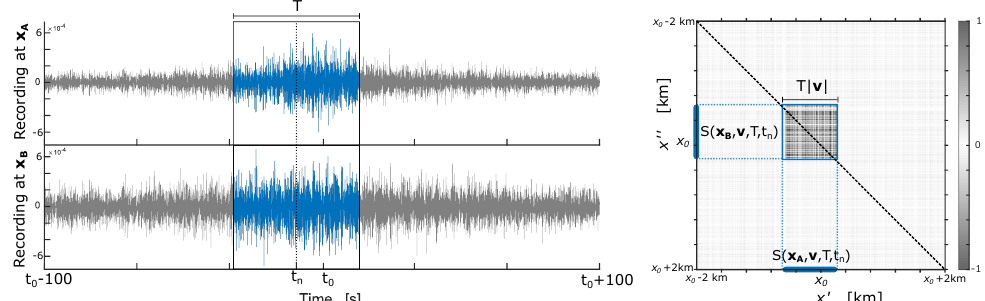
Figure 7. Illustration of the random windowing procedure for a single realization of a window of size T in the temporal domain ( left ), and the corresponding window of length T | v | in the spatial domain ( right ) for v (cid:54) = 0. The panels on the left show the waveforms recorded at a pair of receivers generated by a moving noise source. The approximate time at which the moving source is collinear with the receiver pair is denoted by t 0 , and the location of a window of duration T (blue) is centered around the randomly drawn time t n . The background in the inset on the right shows the spatial part of the source kernel (cid:104) ˆ F ∗ ( x (cid:48) , ω ) ˆ F ( x (cid:48)(cid:48) , ω ) (cid:105) in Equation (6), where x 0 corresponds to the spatial location of the moving source at time t 0 . The boundary of the spatial window, centered at a random location x n = t n | v | , and its projections are highlighted in blue and denoted by S ( x , v , T , t n ) for each receiver; the resulting square window (of size T | v | ) is slightly off the diagonal. The parts of the source kernel excluded from this random window are grayed